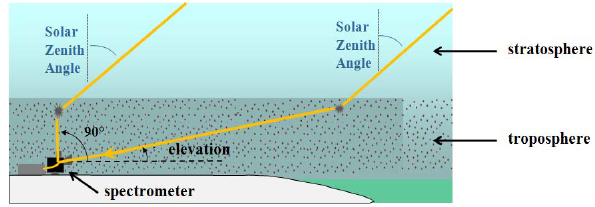
Fig. 1. The principle of MAX-DOAS measurements (Multiple Axis, i.e. elevation scanning, with DOAS spectral analysis): the stratospheric paths at low elevation and zenith are almost identical at low solar zenith angles. Hence if a spectrum at lower elevation is divided by a zenith sky spectrum, the result of the subsequent spectral analysis is only sensitive to the tropospheric absorber amount.